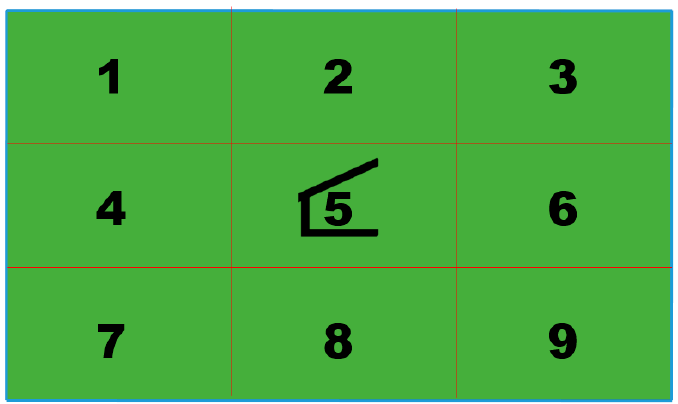
Figure 7. Each paddock was divided into nine equally-sized sections for sampling purposes.